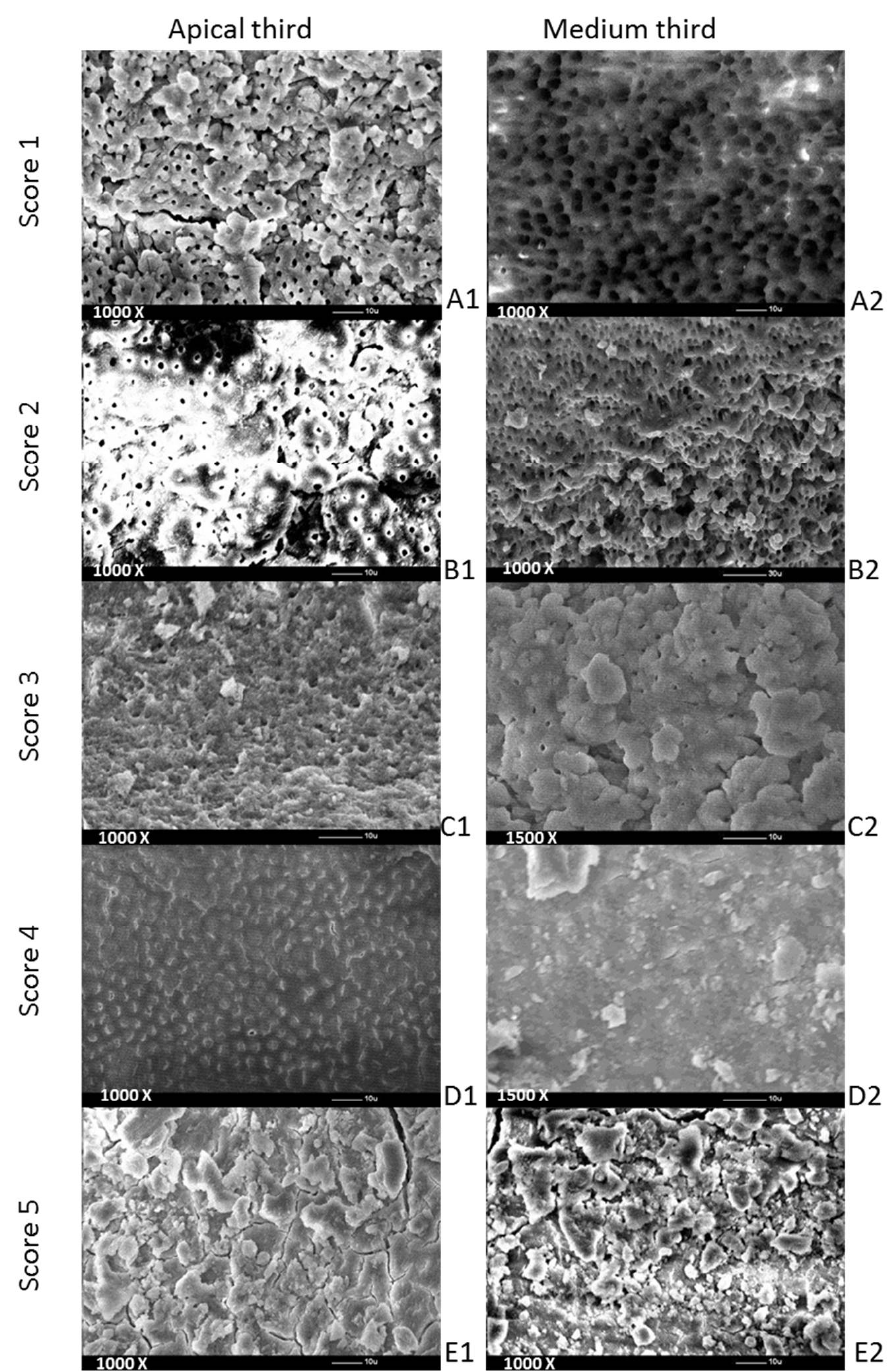
Figure 1. Representative SEM images (magnification of 1000/1500 × ) of smear layer scores from the medium and apical thirds of the root canal after exposure to the 3 final irrigation protocols tested: ( A1 ) NaOCl 5.25% activated using SB, ( A2 ) irrigation with Qx, ( B1 ) NaOCl 5.25% activated using EU, ( B2 ) NaOCl 5.25% activated using EU, ( C1 ) irrigation with Qx, ( C2 ) NaOCl 5.25% activated using SB, ( D1 ) NaOCl 5.25% activated using EU, ( D2 ) NaOCl 5.25% activated using EU, ( E1 ) irrigation with Qx and ( E2 ) NaOCl 5.25% activated using EU.